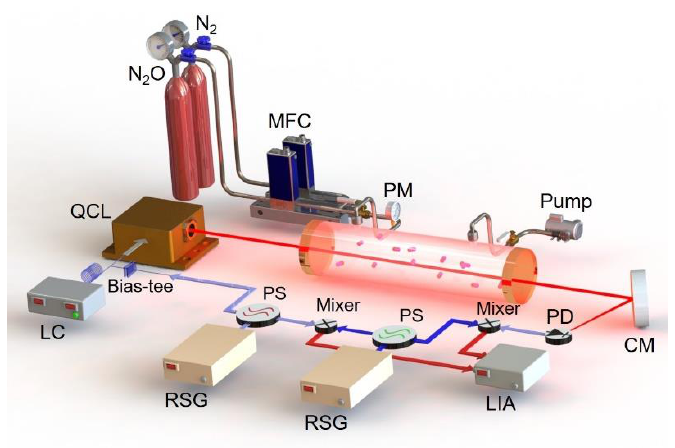
Figure 2. Schematic of the heterodyne phase-sensitive dispersion spectroscopy (HPSDS) gas sensing system. QCL, quantum cascade laser; LC, laser controller; RSG, RF signal generator; LIA, lock-in amplifier; PS, power splitter; PD, photodetector; CM, concave mirror; MFC, mass flow controller; PM, pressure meter.